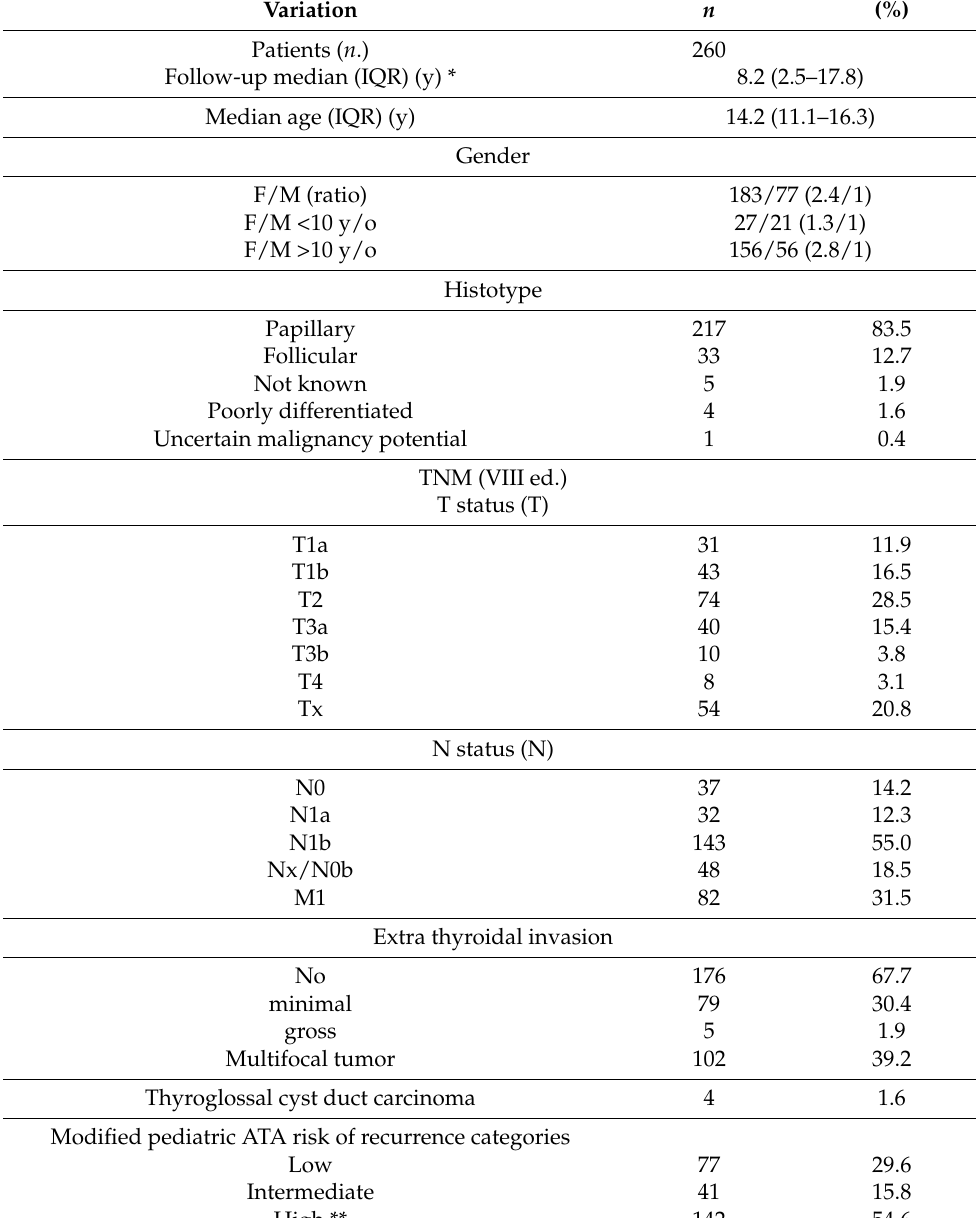
Table 1. Clinical and histopathological characteristics of the 260 pediatric DTC patients aged ≤ 18 years old (y/o) diagnosed between 1956 and 2017. Variation n (%) Patients ( n